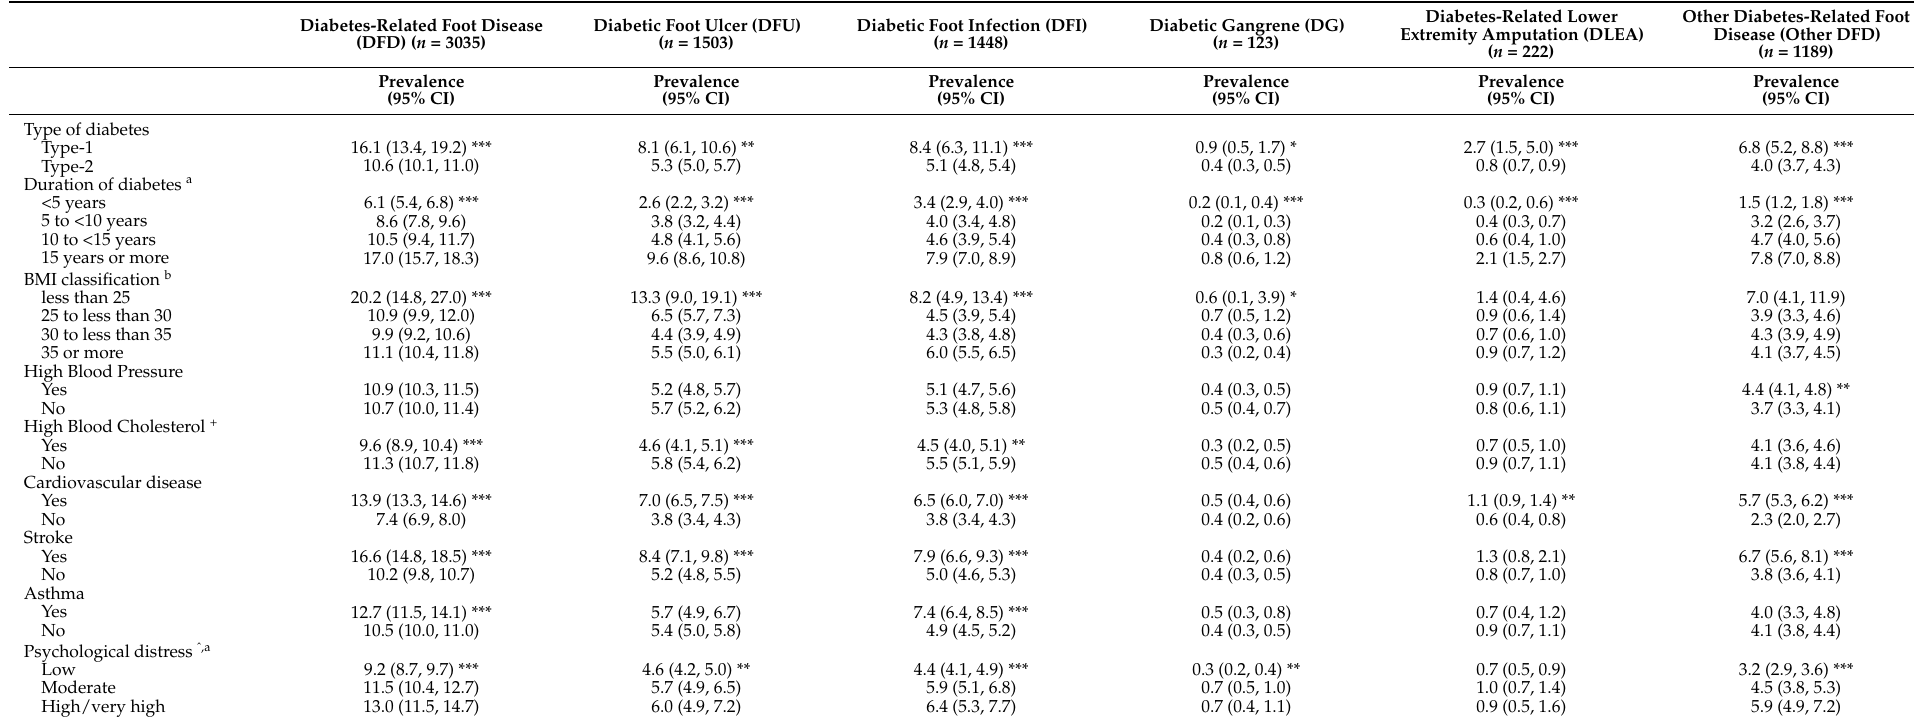
Table 3. Prevalence of DFD, DFU, DFI, DG, DLEA, and other DFD among people with diabetes according to health status factors. Diabetes-Related Foot Disease (DFD) ( n =